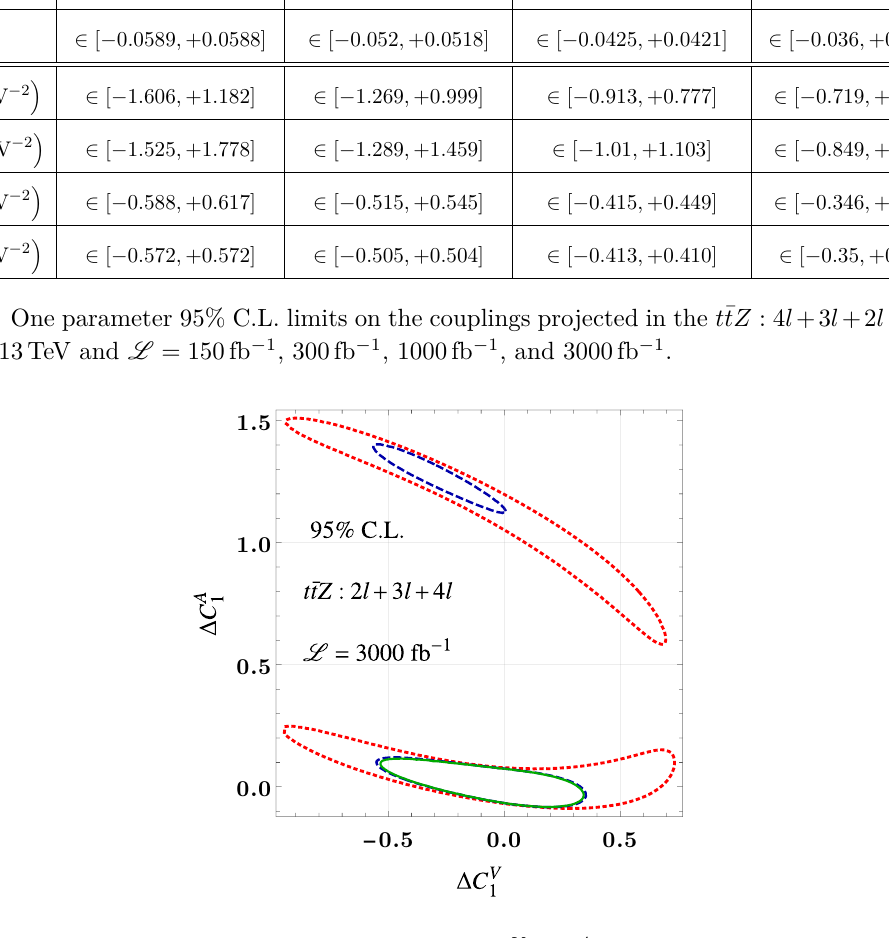
figure 9. The parameter space is tighter compared to only the 4 l channel, as depicted in figure 8. Unlike the 4 l channel, the cross sections divide the parameter space into two regions. The region not containing the SM point is smaller than the point containing the SM point when polarizations are added to the cross sections. The region not containing the SM point further disappears when spin correlations come into play, allowing the parameter space only in the neighborhood of the SM